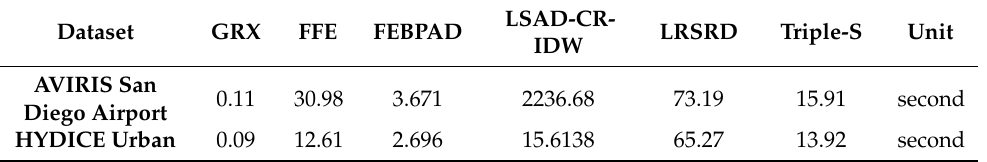
Table 2. Computing time of different methods.